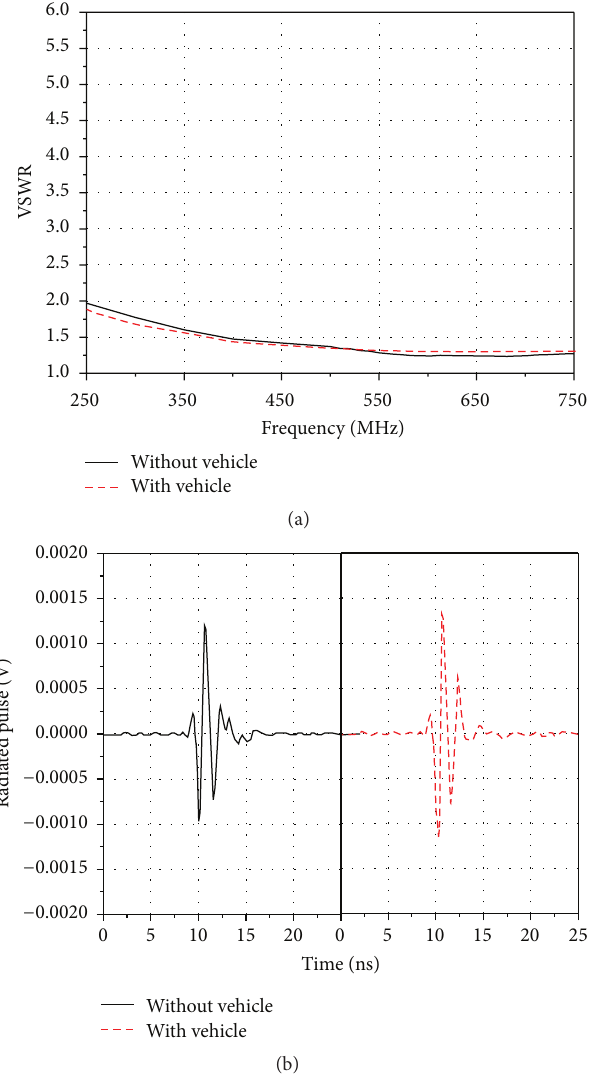
Figure 9: Comparison of resistor-loaded HEA with and without the vehicle: (a) VSWR; (b) radiated